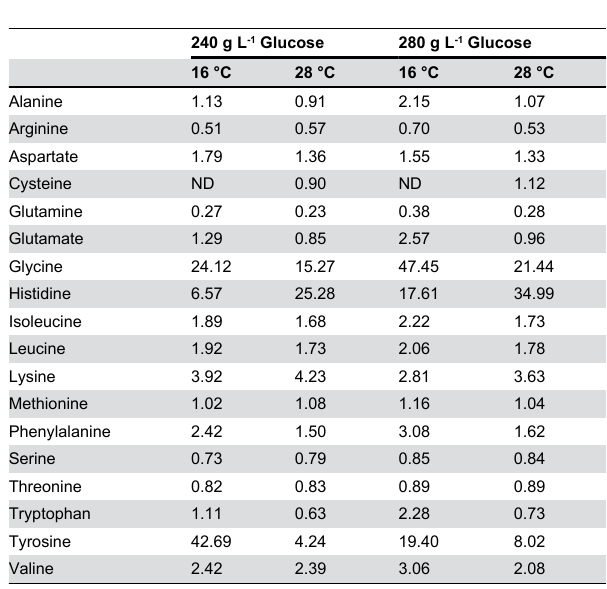
Table 4. Ratio “incorporation rate into the biomass/uptake rate” for each amino